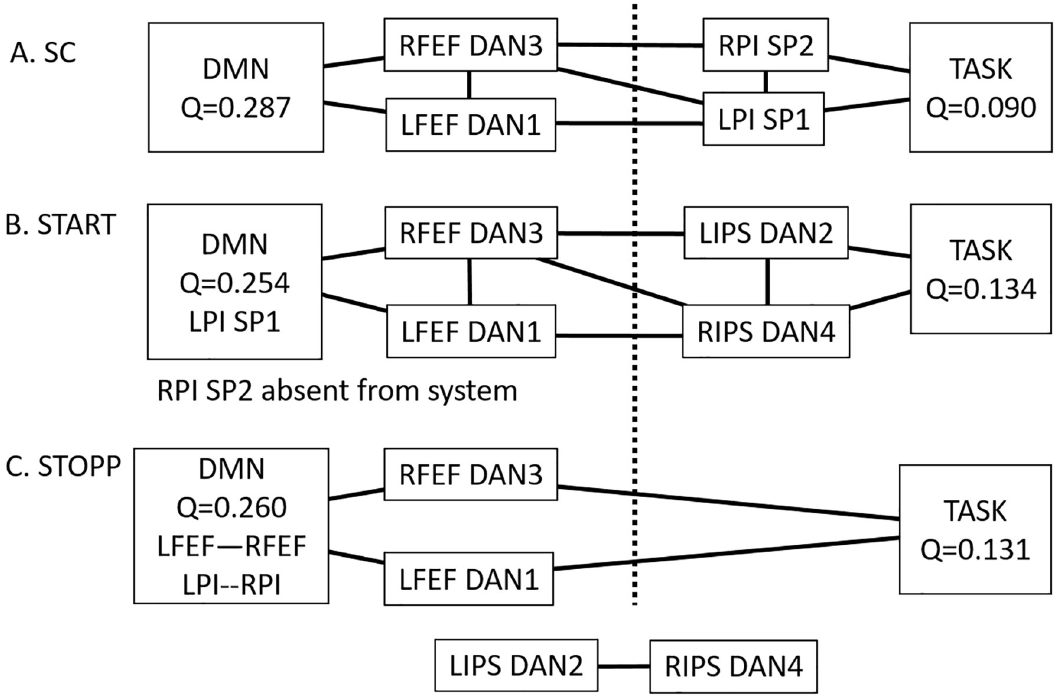
Fig 3. Comparison of bridging nodes and edges between groups. Modularity (Q) was calculated for default and task communities in (A) SC, (B) START, and (C) STOPP. They had 3 patterns of connecting links between DAN nodes. The arrangements of DAN and posterior salience (SP) nodes and edges were different between